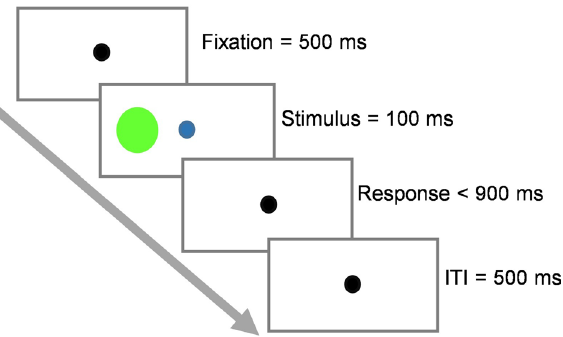
Figure 1. The schematic of a trial. Each trial began with the presentation of the fixation point for 500 ms. The target stimulus was then presented for at most 100 ms. Subjects had 1000 ms to respond following stimulus onset. An inter-trial interval (ITI) of 500 ms, following the response execution or the time-out, concluded the